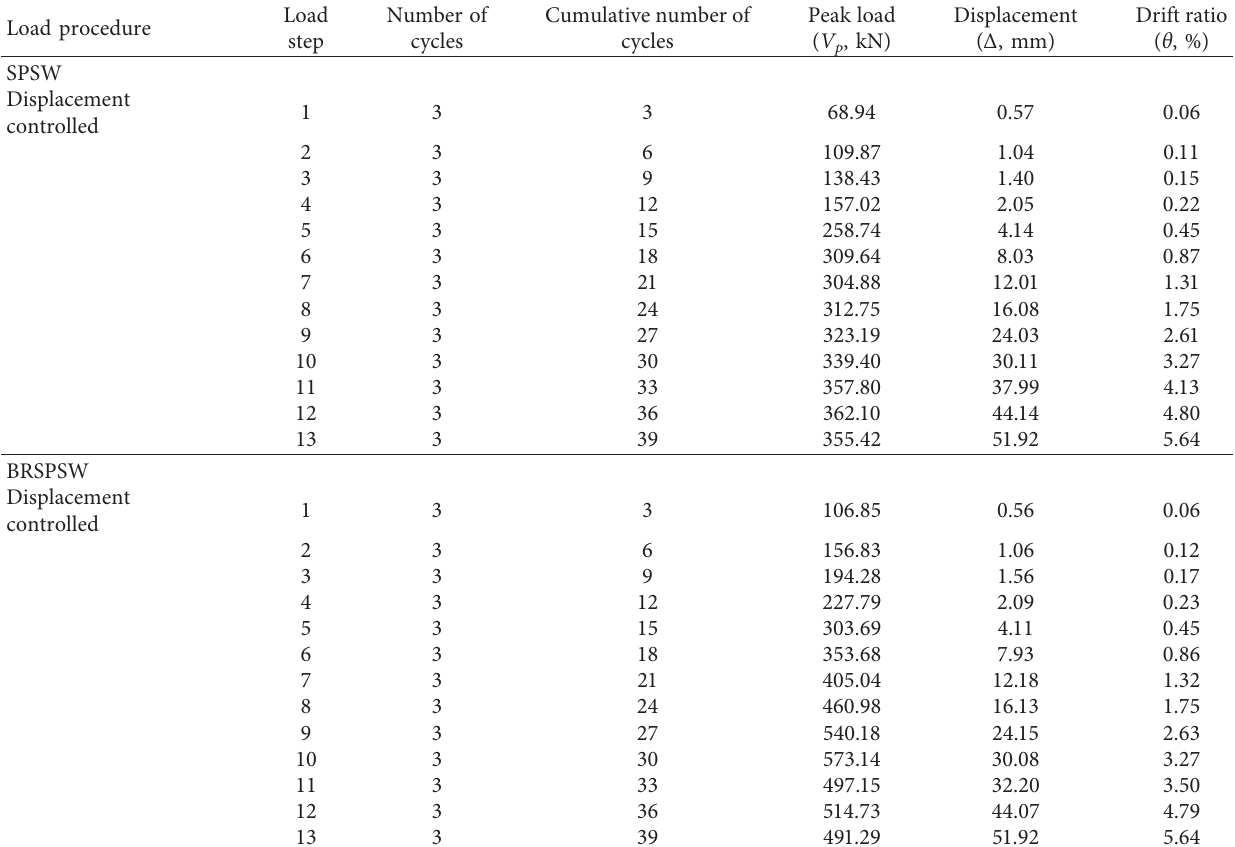
Table 7: Cyclic test histories.